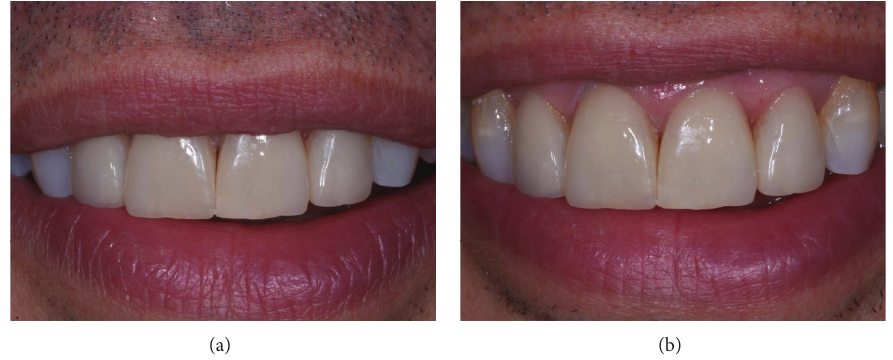
Figure 18: (a)-(b) Postoperative dentolabial views; smile integration of final